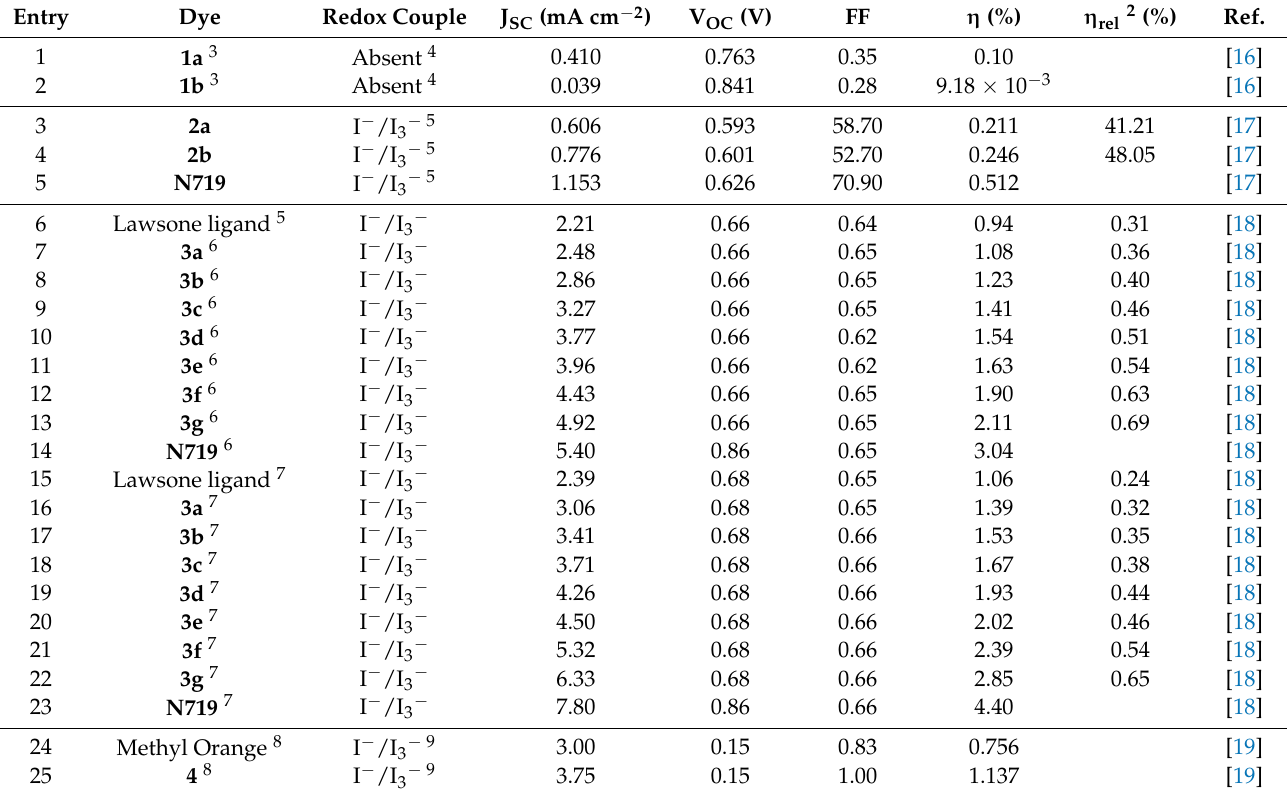
Table 1. Photovoltaic data of DSSCs produced with dyes 1a – b , 2a – b , and 3a – g , 4 1